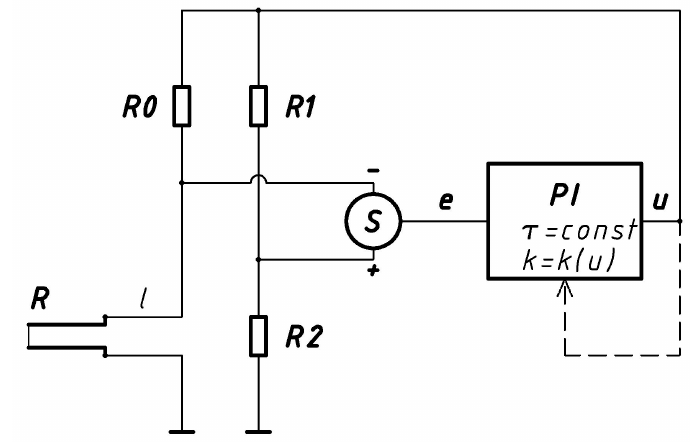
Figure 2. A simplified diagram of the constant-temperature constant-bandwidth anemometer.